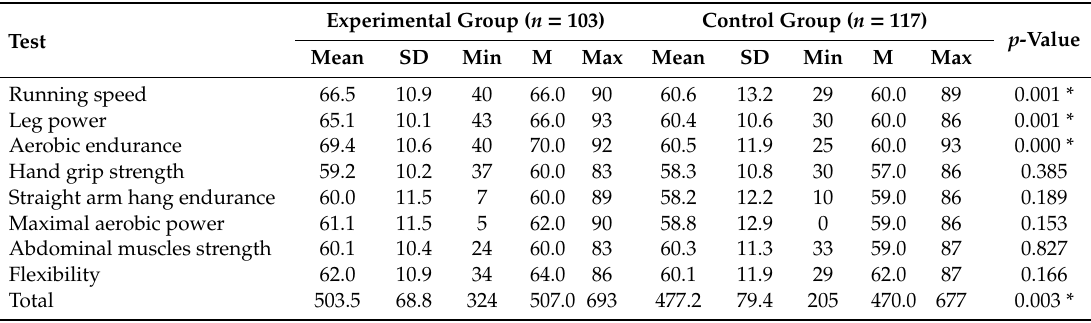
Table 4. Comparison of physical fitness of the students in the experimental group and the control group in the final